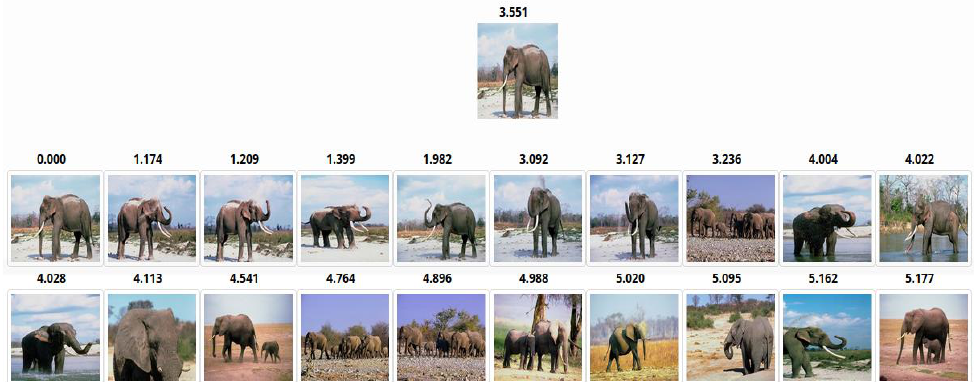
Figure 10. The retrieved images for an Elephant image from the Corel-1000